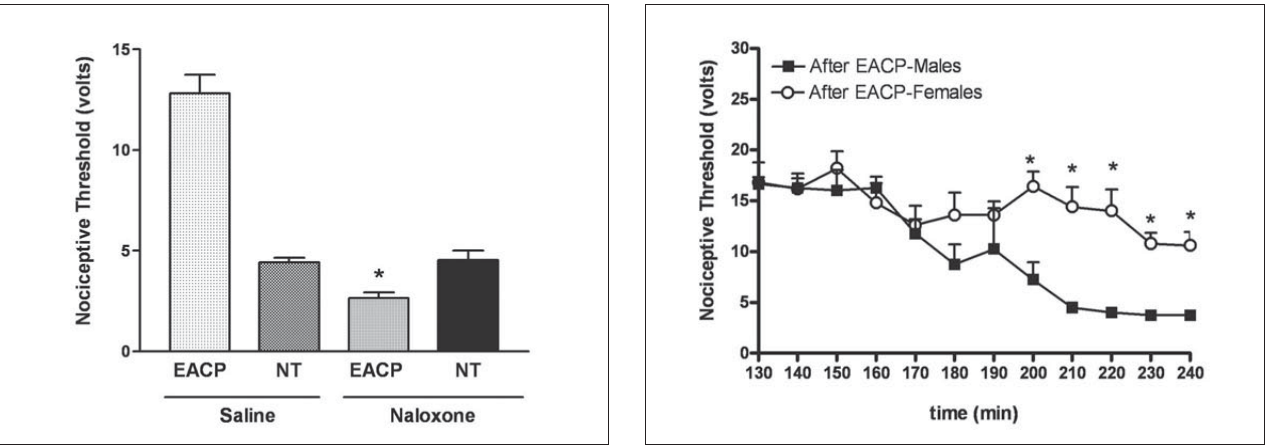
Fig. 3. Effects of pretreatment with naloxone on the analgesic activity of low- frequency electroacupuncture (EACP) in rabbit tooth pulp assay. The nociceptive threshold was measured before and after 30 min of EACP procedure. Animals were pretreated with saline (1 mL; i.p.) or Naloxone (2 mg/kg; i.p.) 10 min before EACP treatment (Yintang, ST4, ST5 acupoints; 2 Hz, 30 mA; 20 min before test up to 120 min). NT represents non-treated animals. Bars represent the means ± SEM of 12 animals per group after 30 min of test. Asterisks indicate statistically significant differences between EACP-Saline group and EACP-naloxone group (*p<0.05; Student’s t-test).